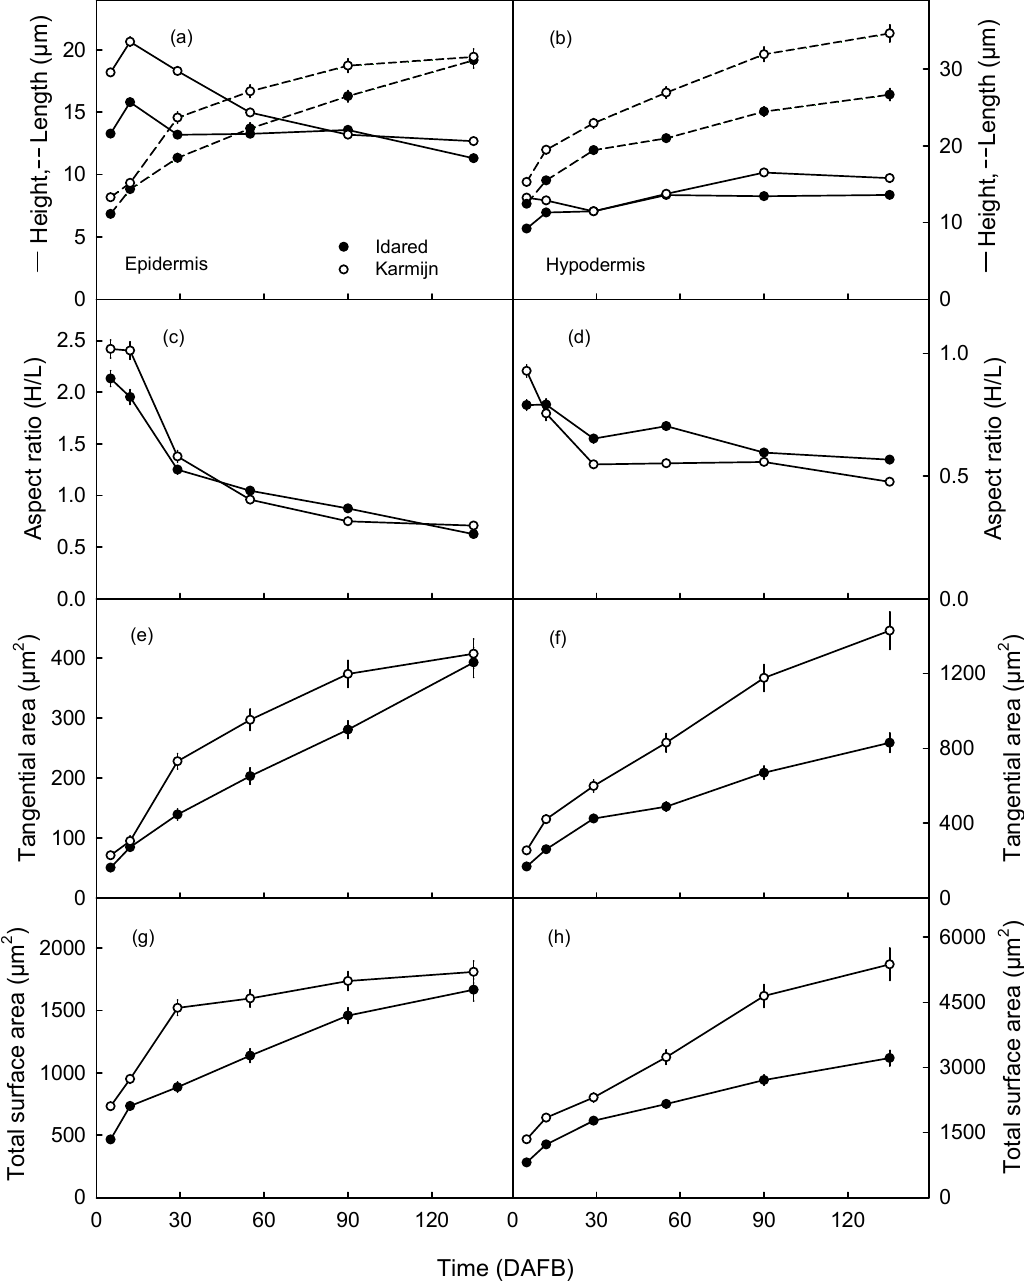
Figure 3. Time courses of change in height and length ( a , b ), aspect ratio (height/length; c , d ), tangential area ( e , f ) and total surface area ( g , h ) of epidermal ( a , c , e , g ) and hypodermal ( b , d , f , h ) cells of ‘Idared’ and ‘Karmijn’ apples. Cell surface area was calculated from cell height and length assuming cells were rectangular prisms. For detail see Methods. Data represent means ± SE. The numbers of replicates were 68–100 (epidermis) and 179–228 (hypodermis) cells. Cells were measured in seven fruit. Where error bars are not visible, they are smaller than the data symbol. DAFB = days after full bloom.